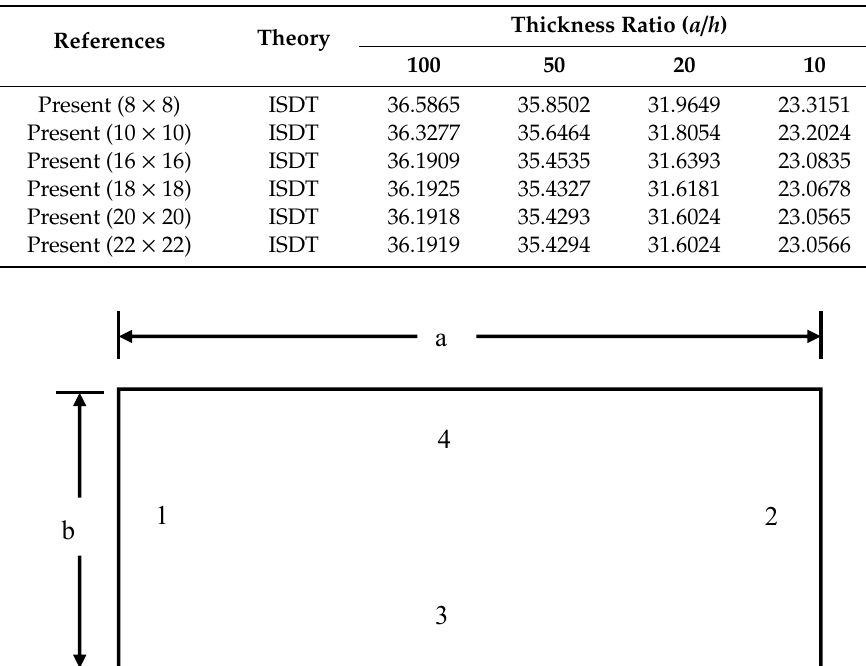
Table 1. Convergence study of nondimensional buckling load λ = ( λ b 2 /E 2 h 3 ) with a / h for a simply